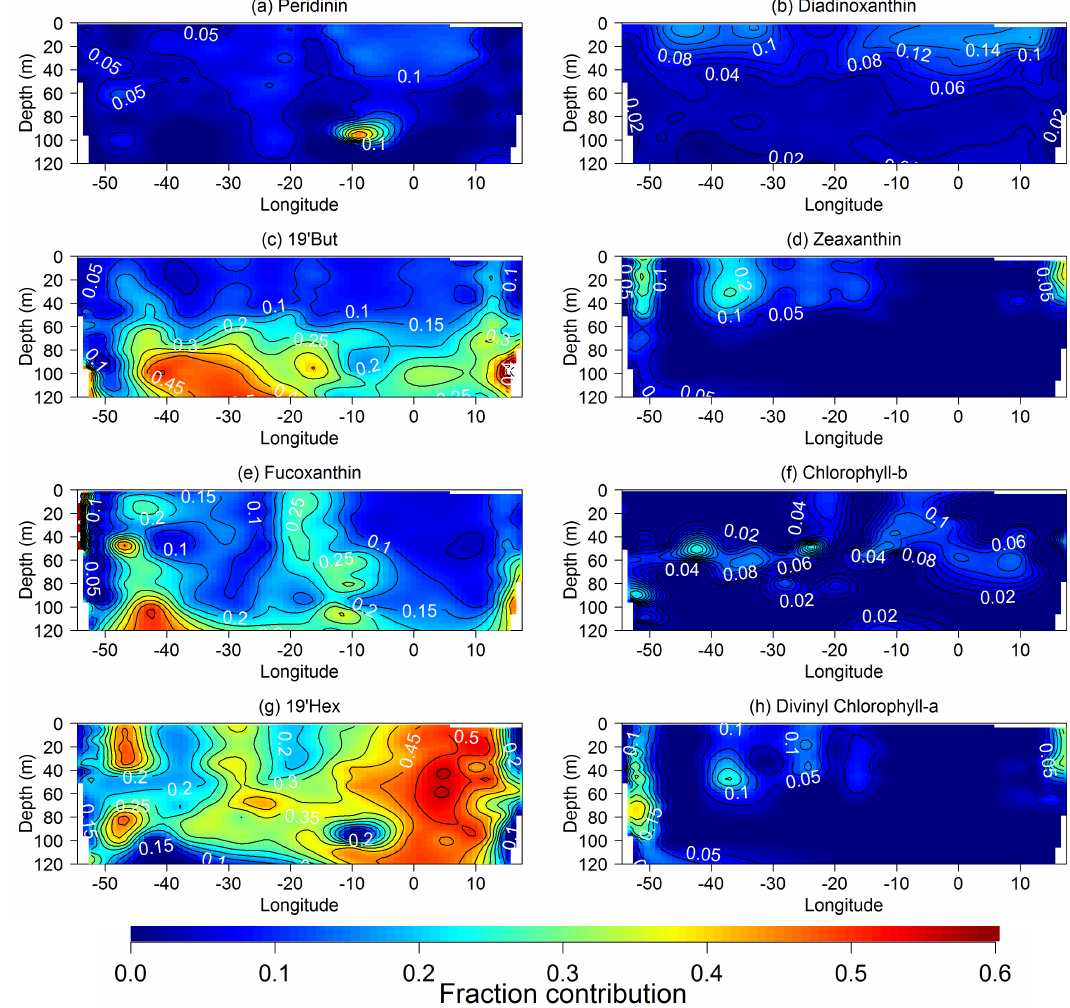
Fig. 5. Cross-basin (depth-longitude) sections of the contribution of major accessory pigments to total accessory pigments (19 0 Hex = 19 0 - hexanoyloxyfucoxanthin, 19 0 But = 19 0